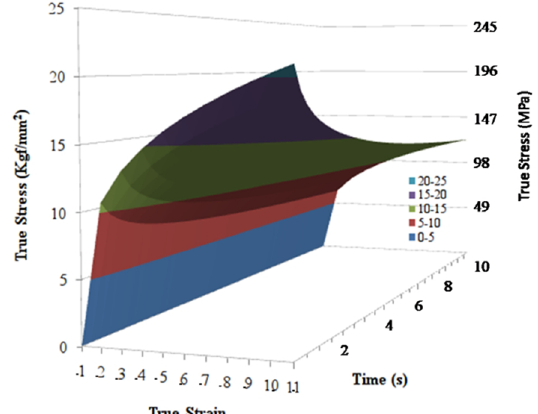
Figure 2. Norton-Bailey equation for copper at 520 °C for strain rates between 0.1 and 1 s -1 . Figure 3 are the Stress-Strain curves obtained with the Voce-Kocks model (VK) (equations 1 to 6) and with Norton- Bailey model (NB) (equations 7 to 10).